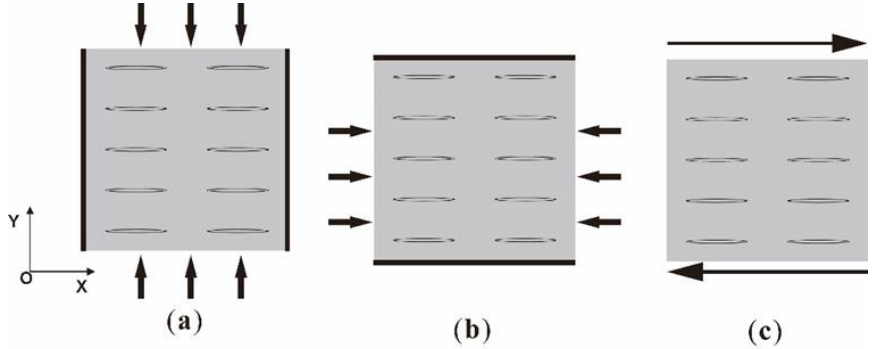
Figure 2. Sketch map of oscillatory relaxation simulation tests to determine 2D stiffness tensors. The back arrows denote the different orientations of solid displacements. Let the solid displacement vertical to the boundary on the black edge lines be zero. ( a ) the first oscillatory relaxation test, a uniform vertical displacement is imposed on the bottom and top boundaries, with two lateral boundaries being confined; ( b ) the second oscillatory relaxation test with a uniform horizontal displacement to the right and left boundaries and the two other boundaries confined; ( c ) the third test, where the top and bottom boundaries are loaded with